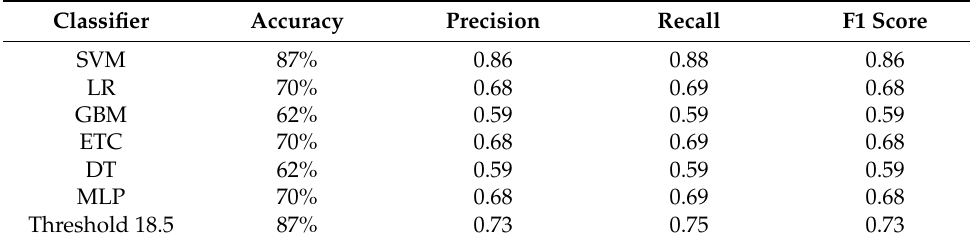
Table 4. Accuracies of